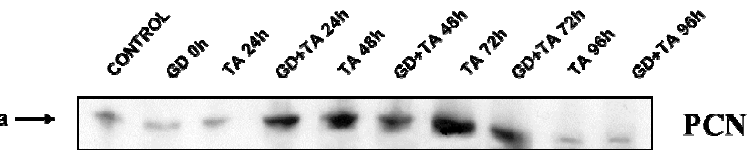
Figure 2. Effect of GD pre-treatment on levels PCNA protein assayed by Western blot in liver homogenates of rats intoxicated with one sublethal dose of thioacetamide. Samples were obtained at 0, 24, 48, 72 and 96 h following thioacetamide (TA). The results, expressed in arbitrary units, are the mean ± SD of four determinations in duplicate from four rats. Differences against the respective control are expressed as (a) and differences due to GD are expressed as (b) p <